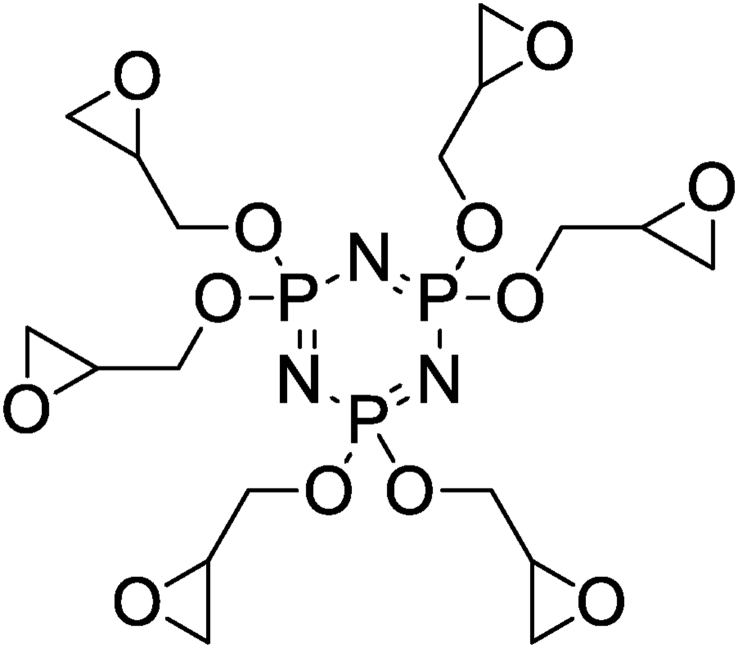
Structure of HGCP [27].